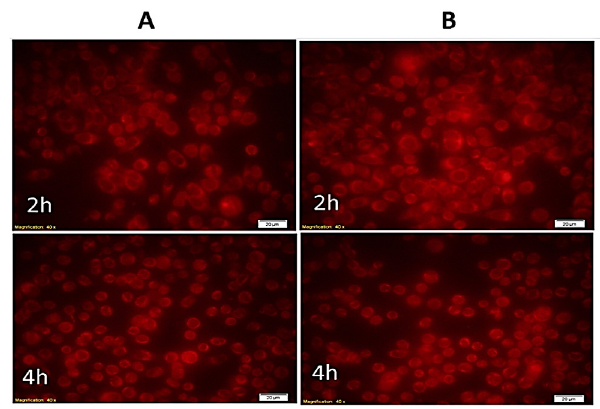
Figure 2: DOX loaded nanocarrier uptake by MCF-7 cells. A. Cells treated with free Rhodamine. B. Cells treated with DOX loaded